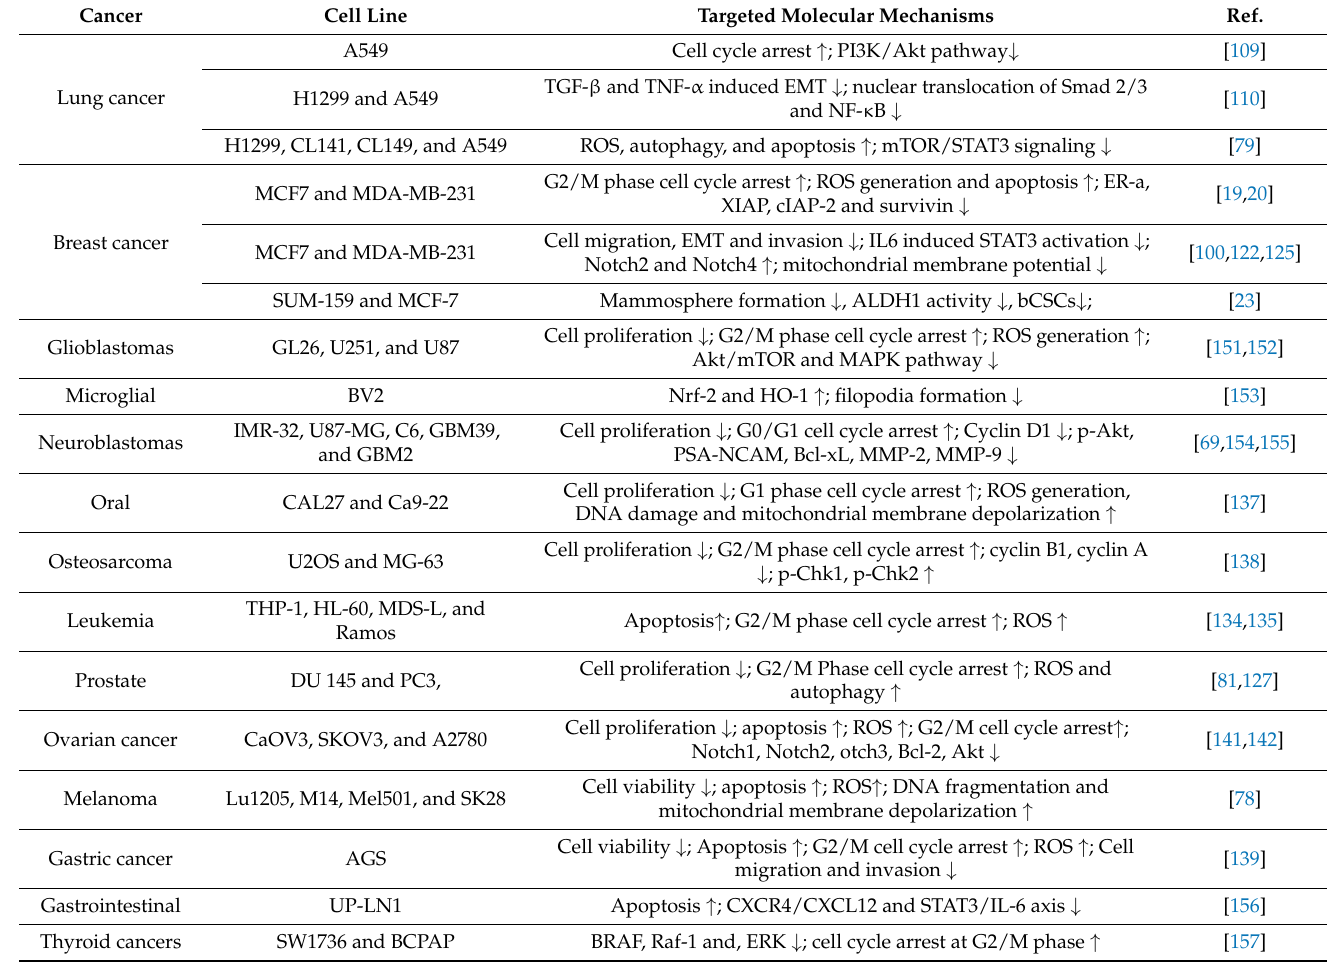
Table 2. In vitro cytotoxic activity and targeted molecular mechanisms of Withania somnifera in different cancer